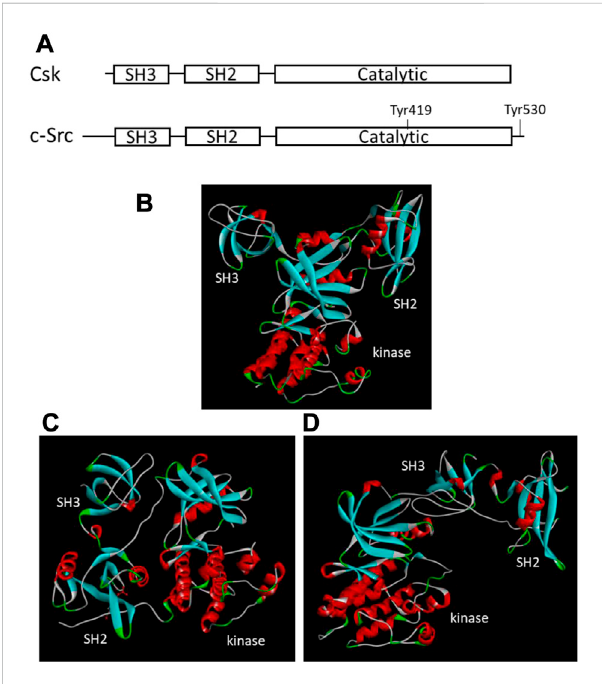
FIGURE 1 Structural organizations and tertiary structures of Csk and Src. (A) . Domain organization of Csk and Src. The key domains and Tyr residues important for regulation are indicated. (B) . Tertiary structure ofCsk(PDBID1k9A,Ogawaetal.,2002). (C) .Tertiarystructureof Src when Tyr530 is phosphorylated (PDB ID 1FMK, Xu et al., 1999). (D) . Tertiary structure of Src when Tyr530 is unphosphorylated (PDB ID 1Y57, Cowan-Jacob et al., 2005). The structural images are generated using Discovery Studio